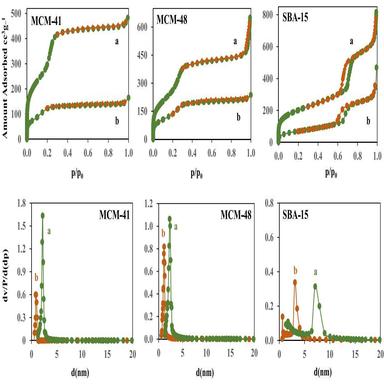
(A) BET isotherm and Fig. 2(B) Pore size distribution of a calcined ordered mesoporous material, b Zn complex incorporated ordered mesoporous materials.